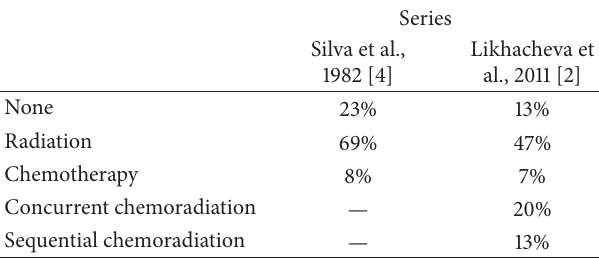
Table 2: Treatment following primary surgery with or without neoadjuvant chemotherapy.